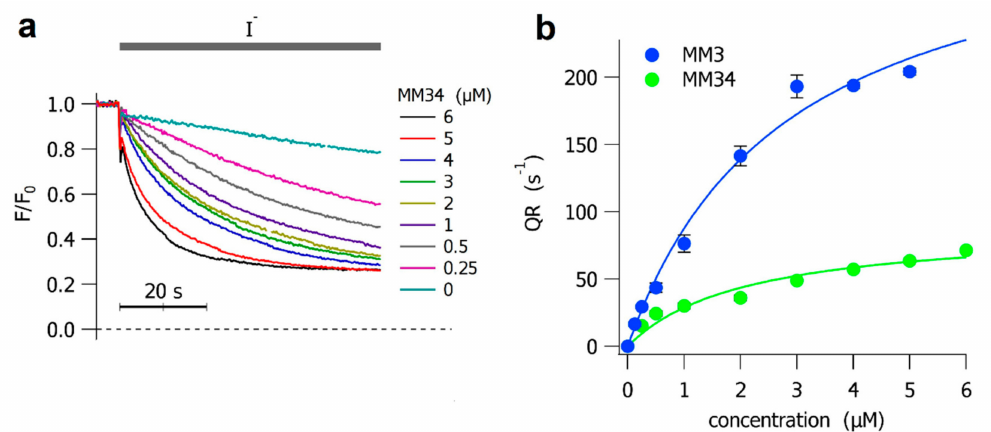
Figure 2. Anionophore-driven halide transport in Fischer Rat Thyroid (FRT) cells. ( a ) The time course of the fluorescence decay in FRT cells incubated at di ff erent concentrations of MM34, as indicated. The addition of iodide is indicated by the gray line over the traces. Cells treated with DMSO were used as control. The time-calibration bar is shown below the traces. ( b ) The initial YFP-quenching rate (QR) obtained from FRT cells treated with di ff erent concentrations of MM3 (blue) and MM34 (green). Each point represents the means ± SEM from 8 experiments. The concentration–response curves, fitted with a Langmuir model, are represented as continuous lines.